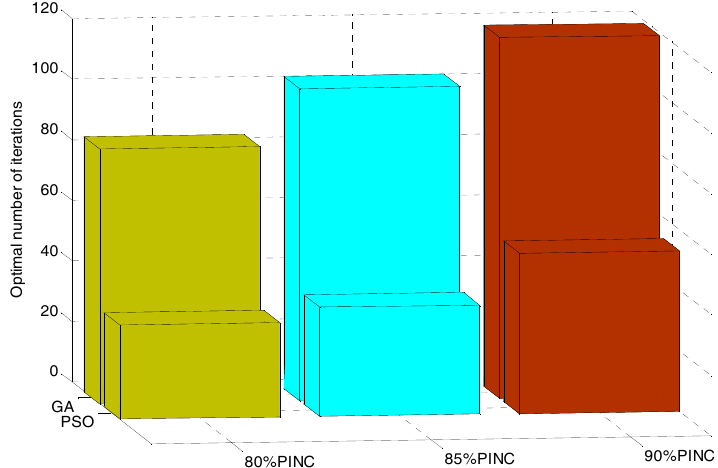
Figure 14. Number of iterations needed to obtain the optimal solution for the PSO and GA optimization.